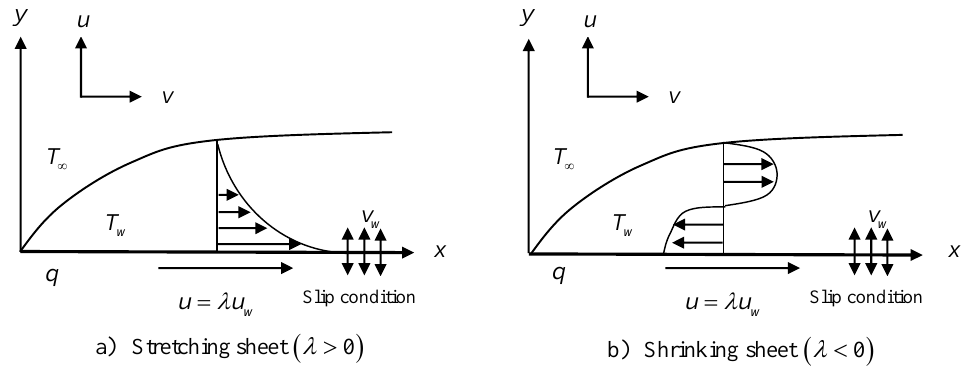
Figure 1. Physical model.